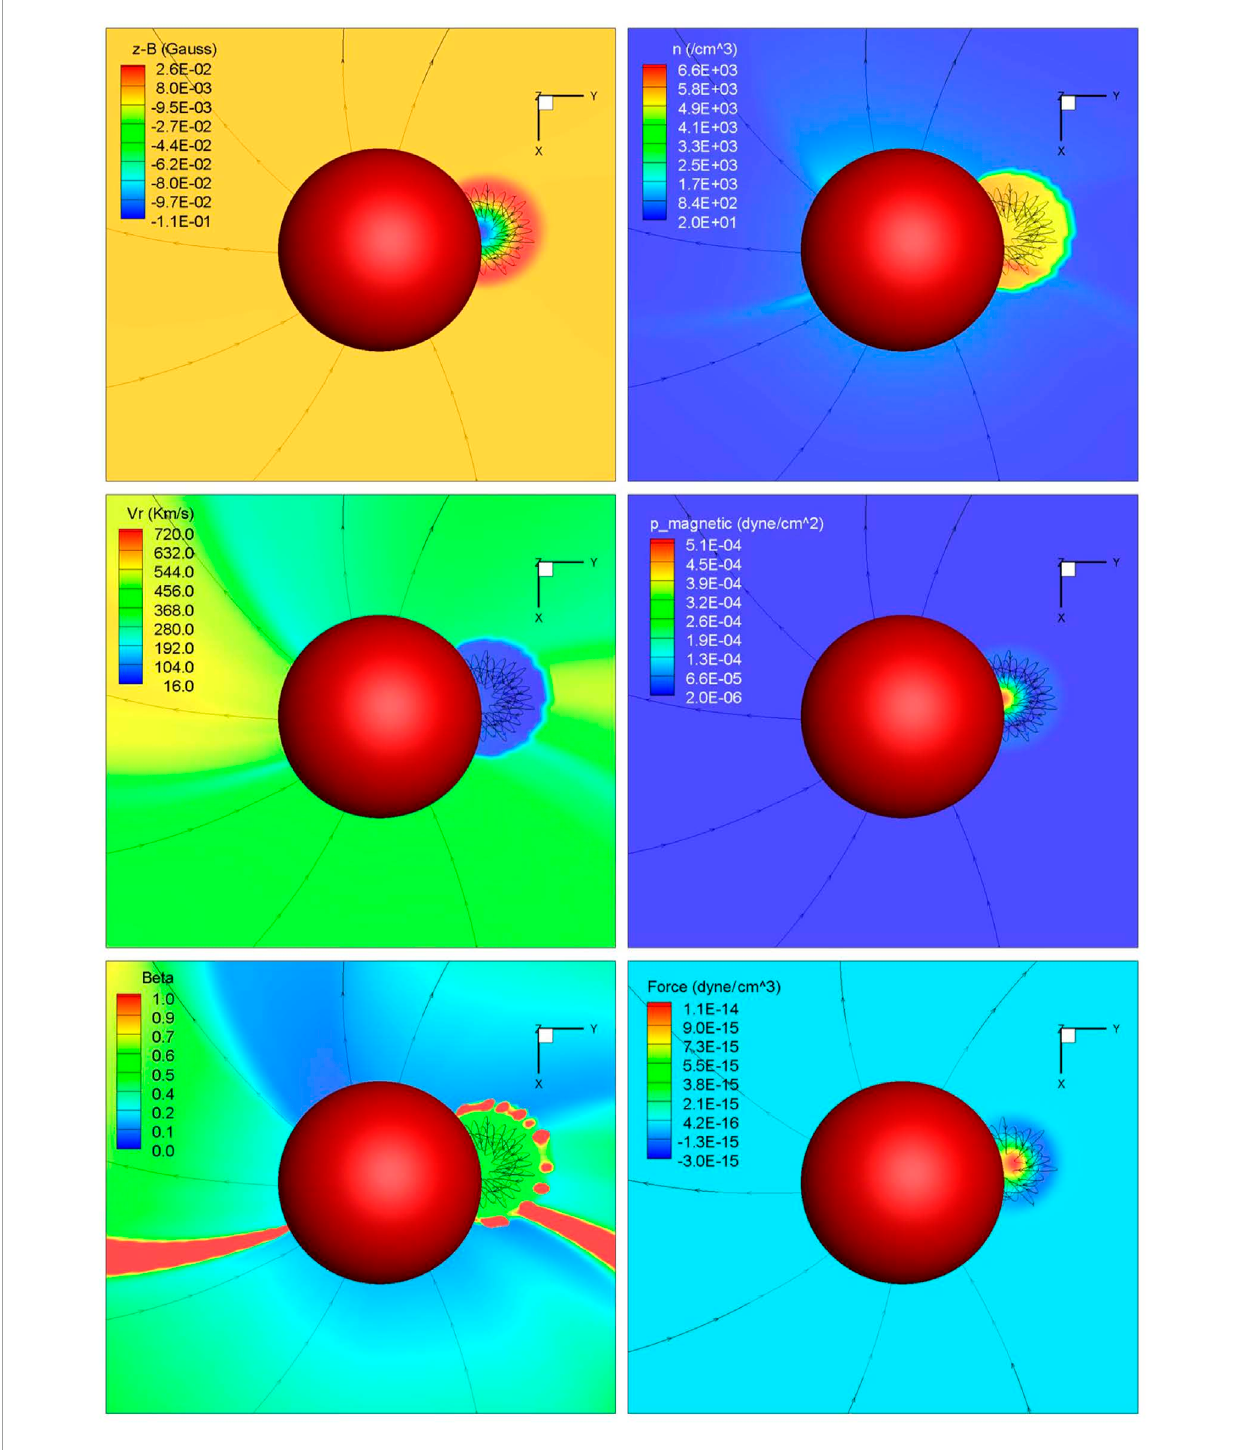
FIGURE 14 Magnetic field line configuration of the modified spheromak inserted at the inner boundary R = 0.1 AU, shown with the red sphere (Singh et al., 2020).